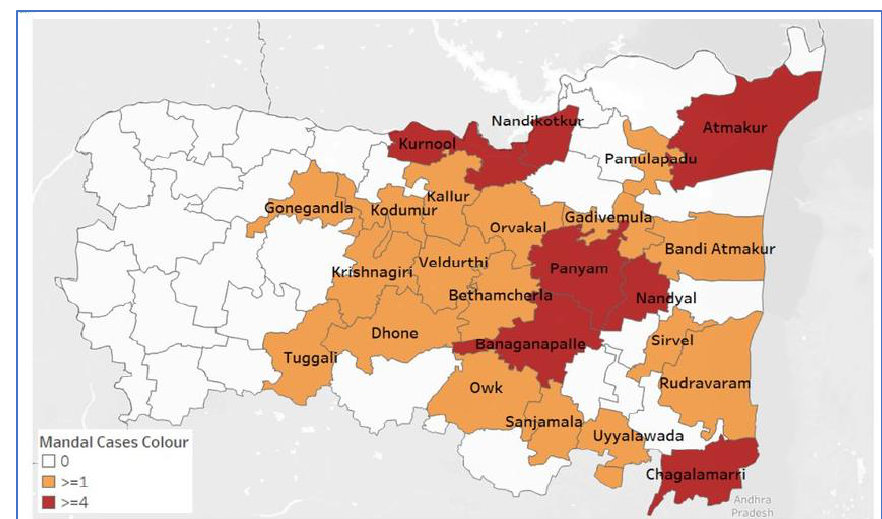
Figure 1. Administrative map of Kurnool District and the COVID-19 affected Mandalas. Data as on 25 th April 2020